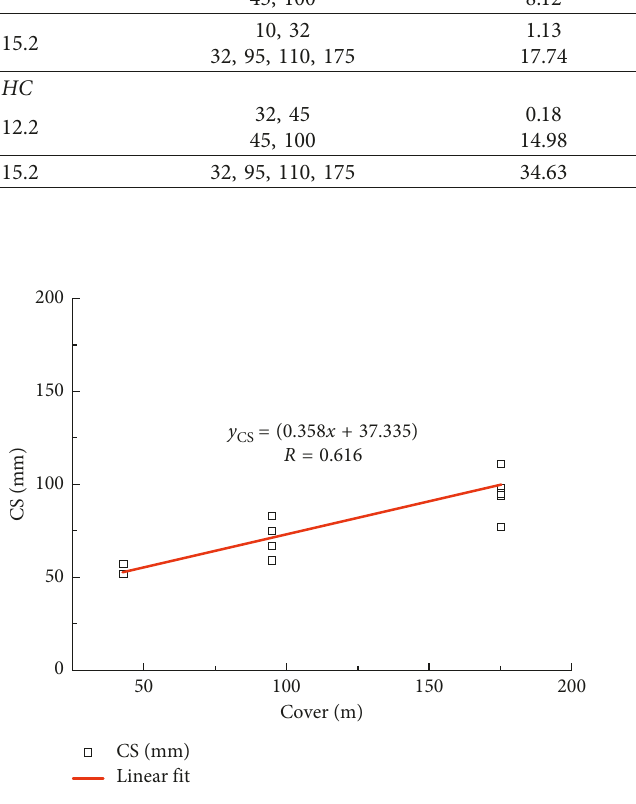
Figure 8: Linear regression between HC and cover depth at 15.2m